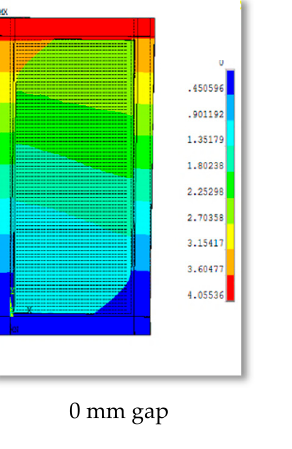
Figure 10. Out-of-plane displacement for the various gaps between the steel frame and concrete wall.